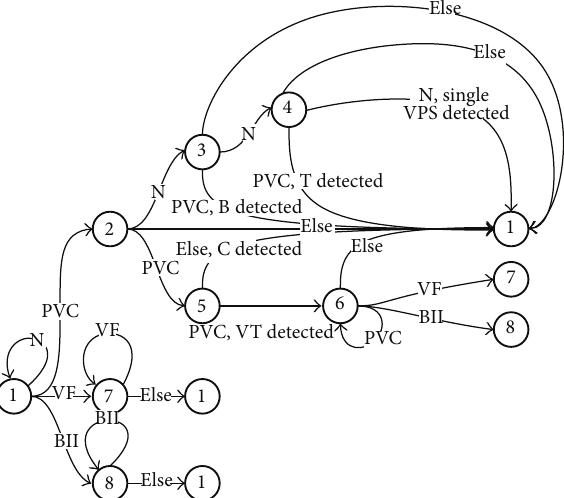
Figure 6: Arrhythmic episode classification by the